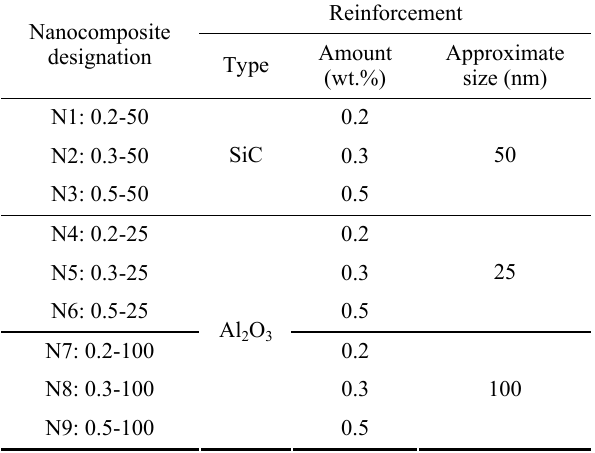
Table 2 Designation of the tested nanocomposites and used